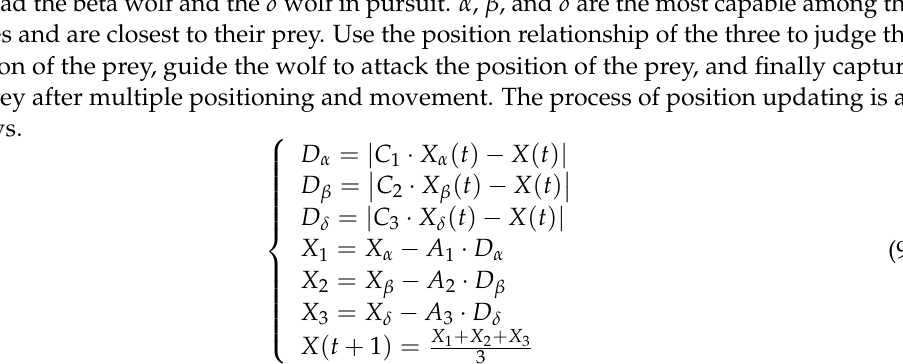
Figure 2. The social hierarchy of the grey wolves.